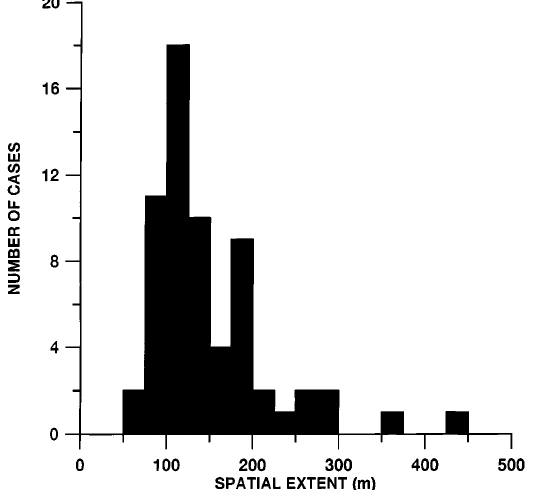
Fig. 6. The distribution of the spatial extent d